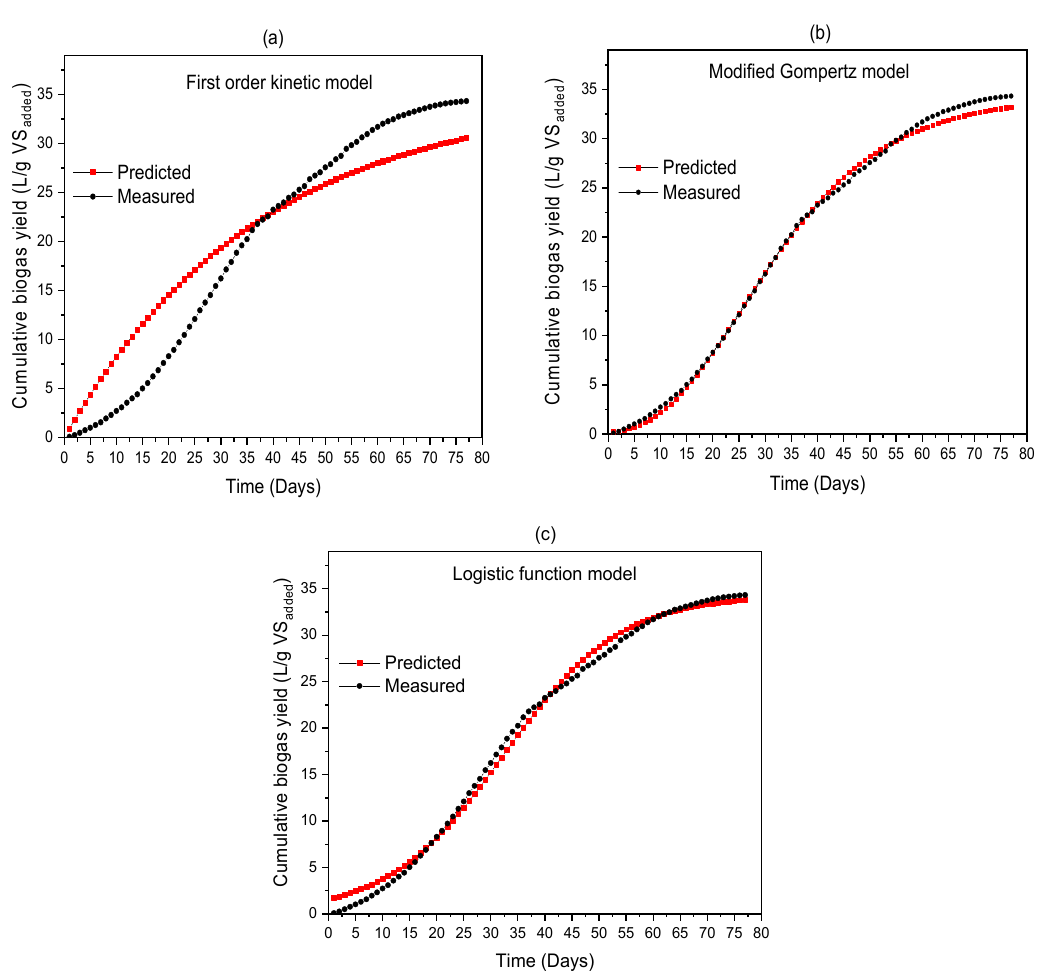
Figure 5. Cumulative biogas yield from the ( a ) first-order kinetic model, ( b ) modified Gompertz model, and ( c ) logistic function model.